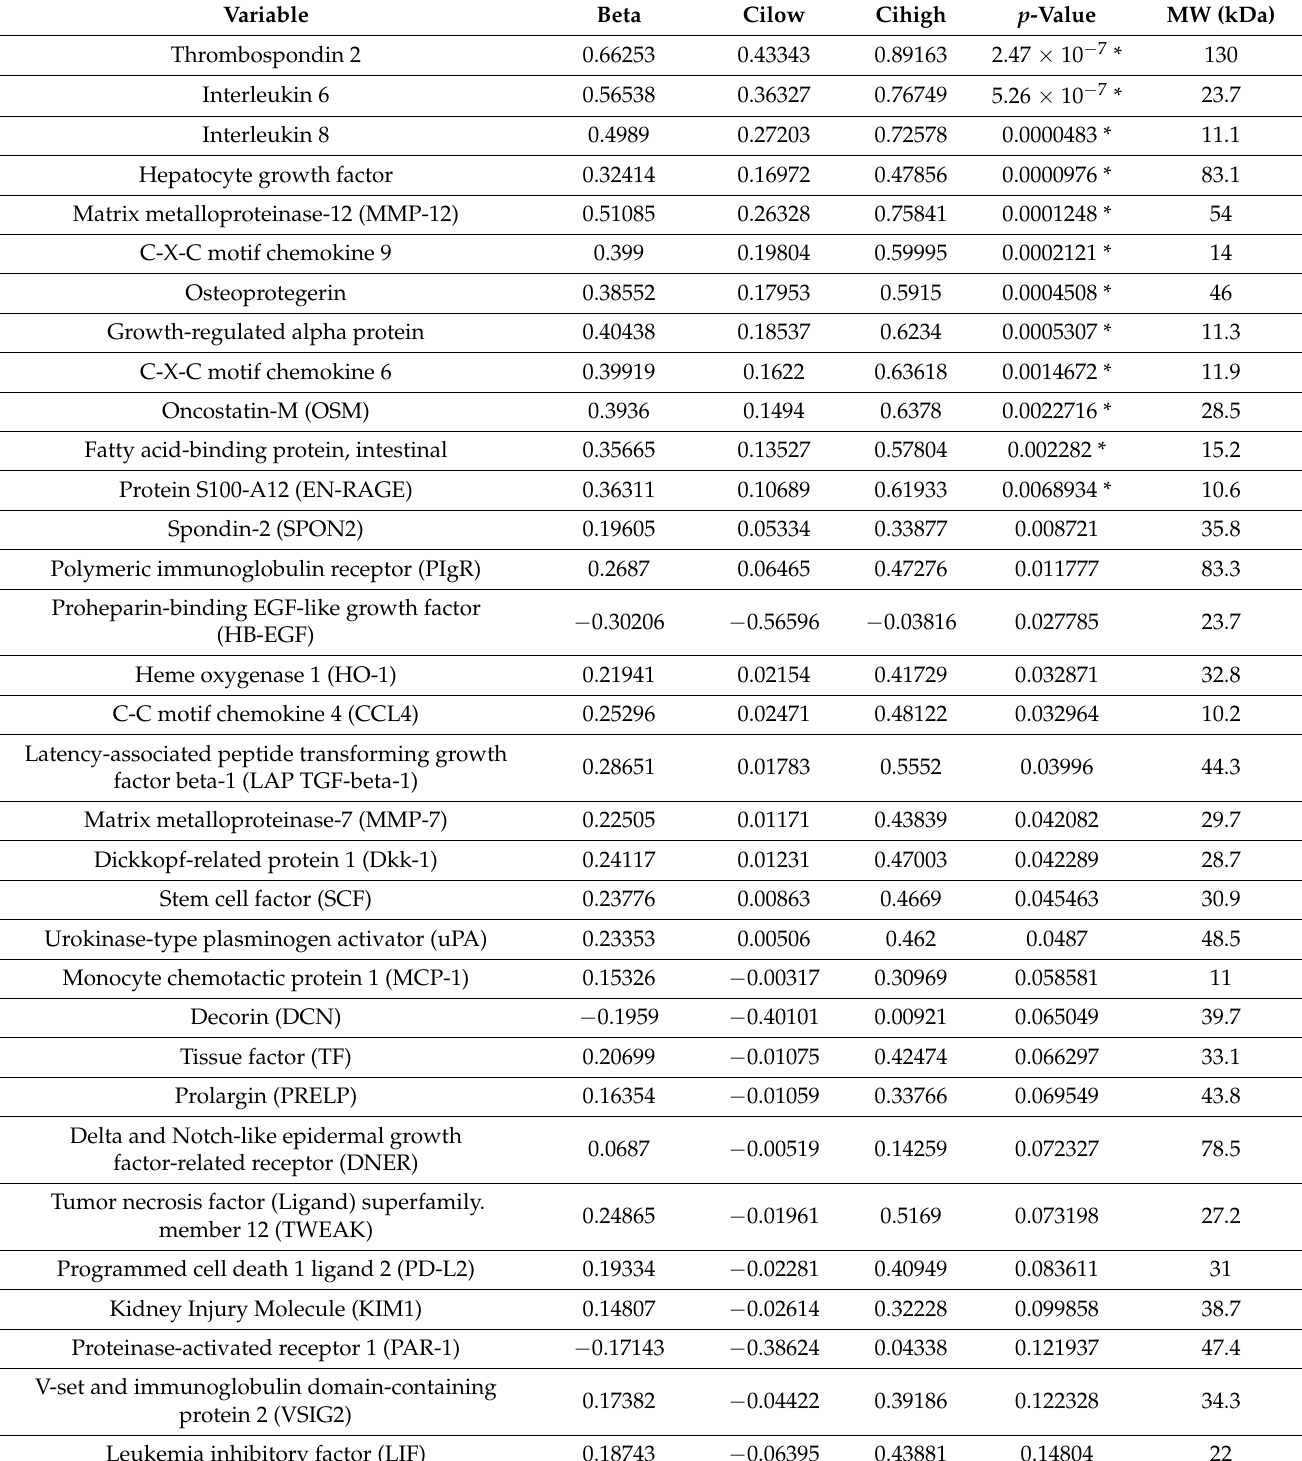
Table 2. Relationships between 79 urinary proteins and urinary albumin adjusted for sex, urinary creatinine, estimated glomerular filtration rate (eGFR), body mass index (BMI), smoking and exercise habits. Protein levels were measured on a log2-scale and transformed to a standard deviation (SD)-scale. The results are presented as Beta value, low (Cilow) and high (Cihigh) confidence intervals, p -values. FDR significance is given for each level of adjustment. The order is sorted on p -value. For comparison the molecular weight for each biomarker is presented in the right-hand column. Adjustment for Sex, Urinary Creatinine, eGFR, BMI, Smoking and Exercise